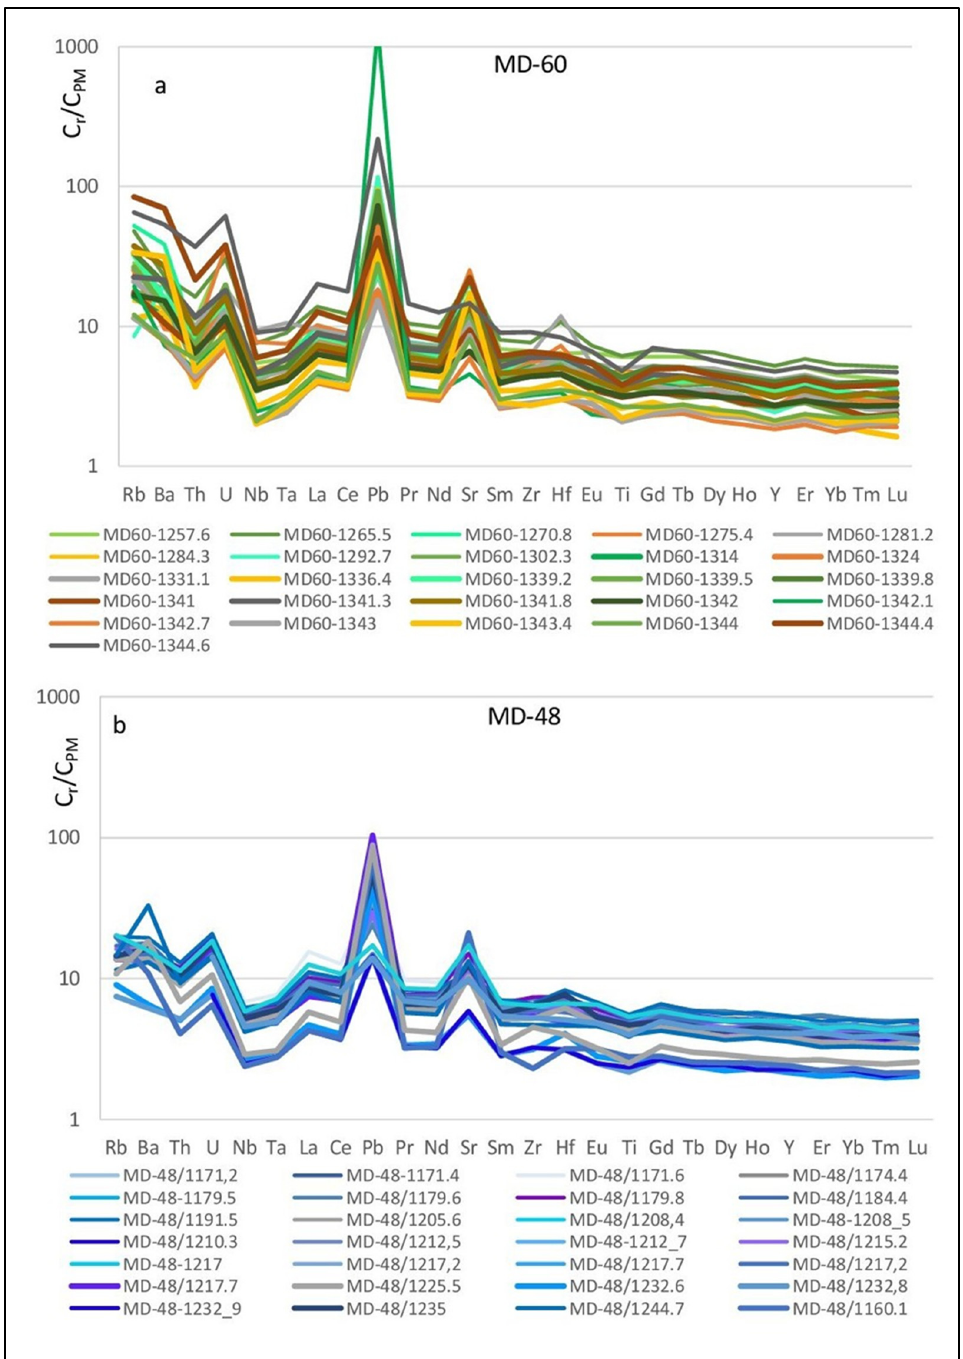
Figure 7. Spider-diagrams for rocks from the MD-60 ( a ) and MD-48 ( b ) borehole (normalized to PM after Hofmann, 1988).